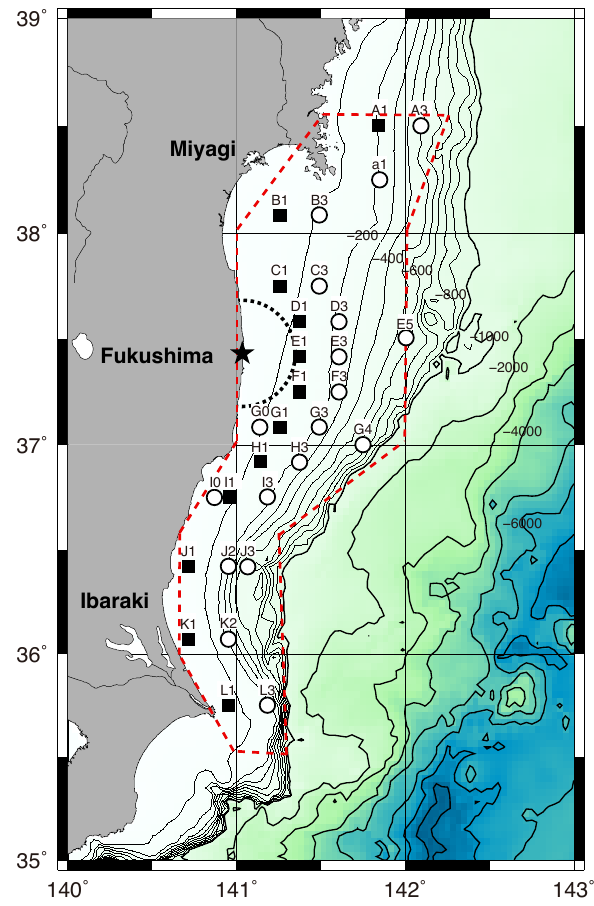
Fig. 2. Locations of sampling stations. Solid squares indicate sta- tions where sediment samples were collected on 10 dates from May 2011 to February 2012, and open circles indicate stations where samples were collected on 4 dates from September 2011 to Febru- ary 2012. The star indicates the location of the Fukushima Dai-ichi Nuclear Power Plant, and the dashed black semicircle encloses the area within a 30km radius of the plant. 137 Cs inventories in the sed- iments were estimated for the area enclosed by the red dashed line (see Sect.